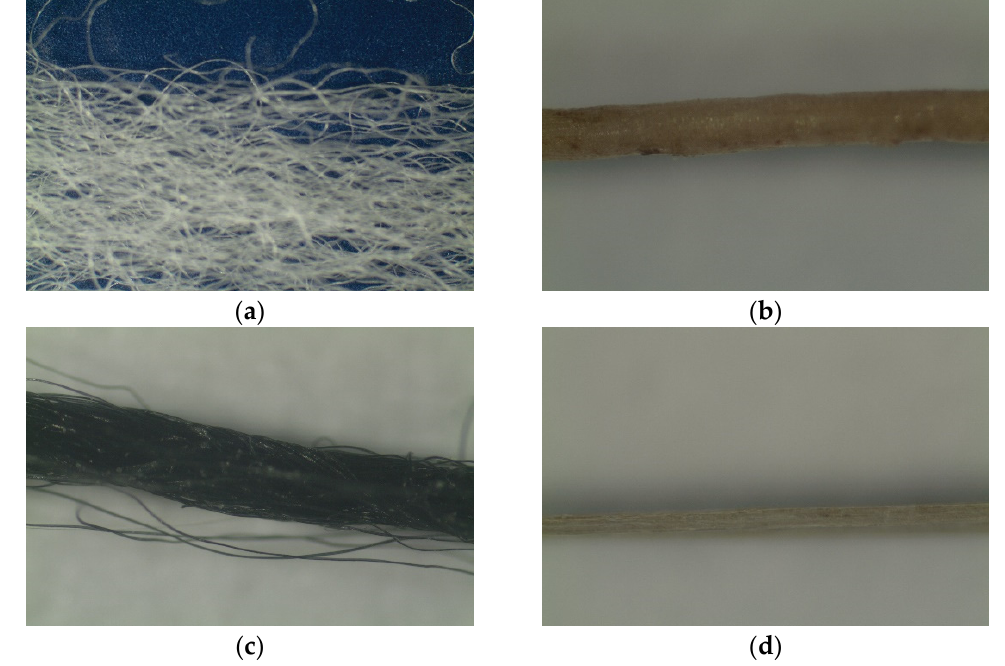
Figure 2. Micrographs: ( a ) wool fibres, ( b ) coir fibres, ( c ) textile-acrylic fibres and ( d ) flax fibres. The aspect ratio of the fibres is presented in Table 1 .